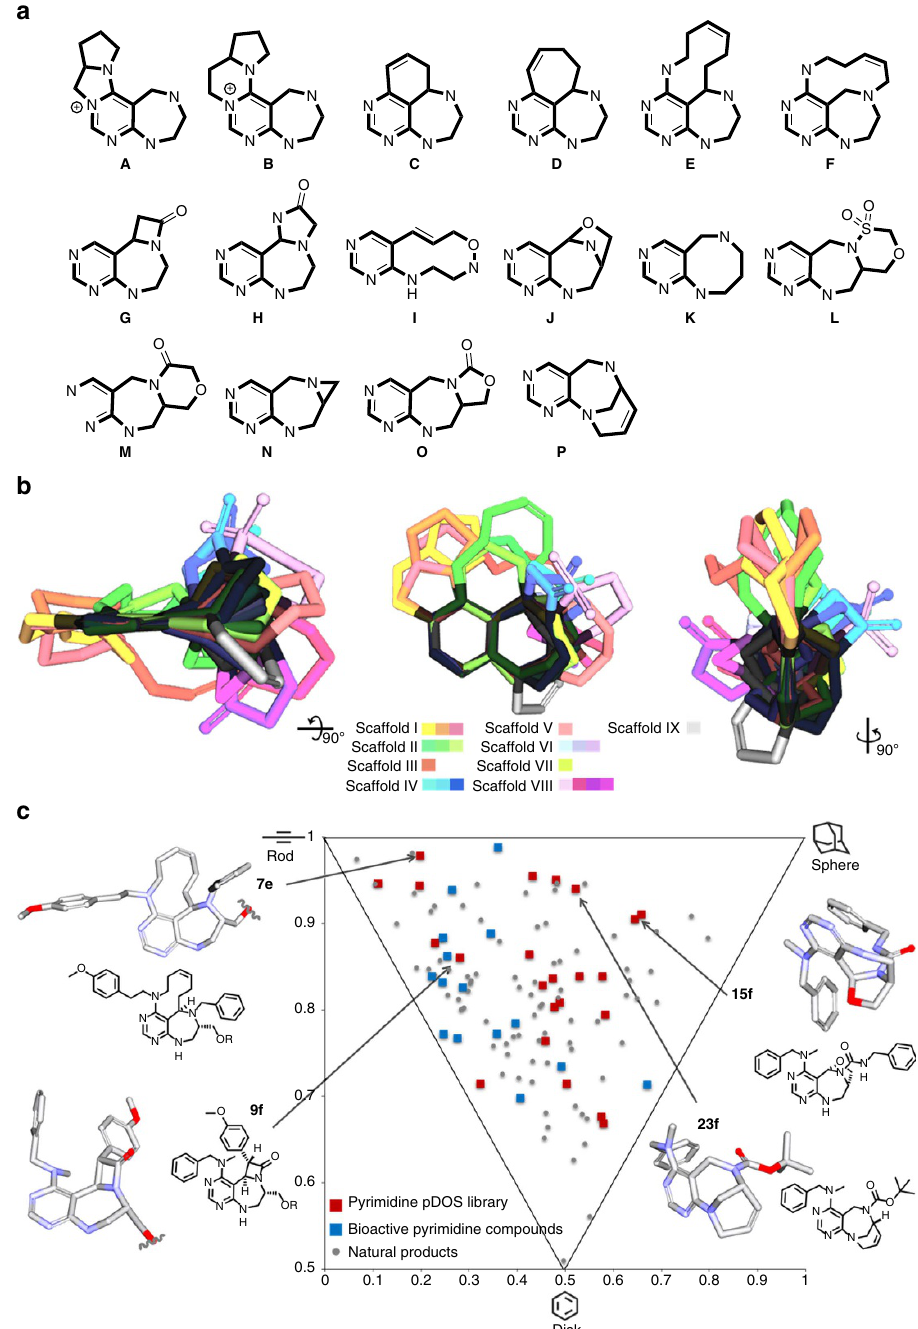
Figure 4 | Chemoinformatic analysis for structural diversity and 3D complexity of pDOS library. ( a ) Core skeletons of 16 natural product-like pyrimidodiazepine- or pyrimidine-containing polyheterocycles. ( b ) Overlay of energy-minimized conformers of 16 core skeletons aligned by the pyrimidine substructure. ( c ) PMI plot. The 3D molecular shape of pDOS library (red squares) was quantitatively compared with that of 15 FDA-approved drugs embedded with pyrimidine moiety (blue squares) and 71 bioactive natural products (grey dots).